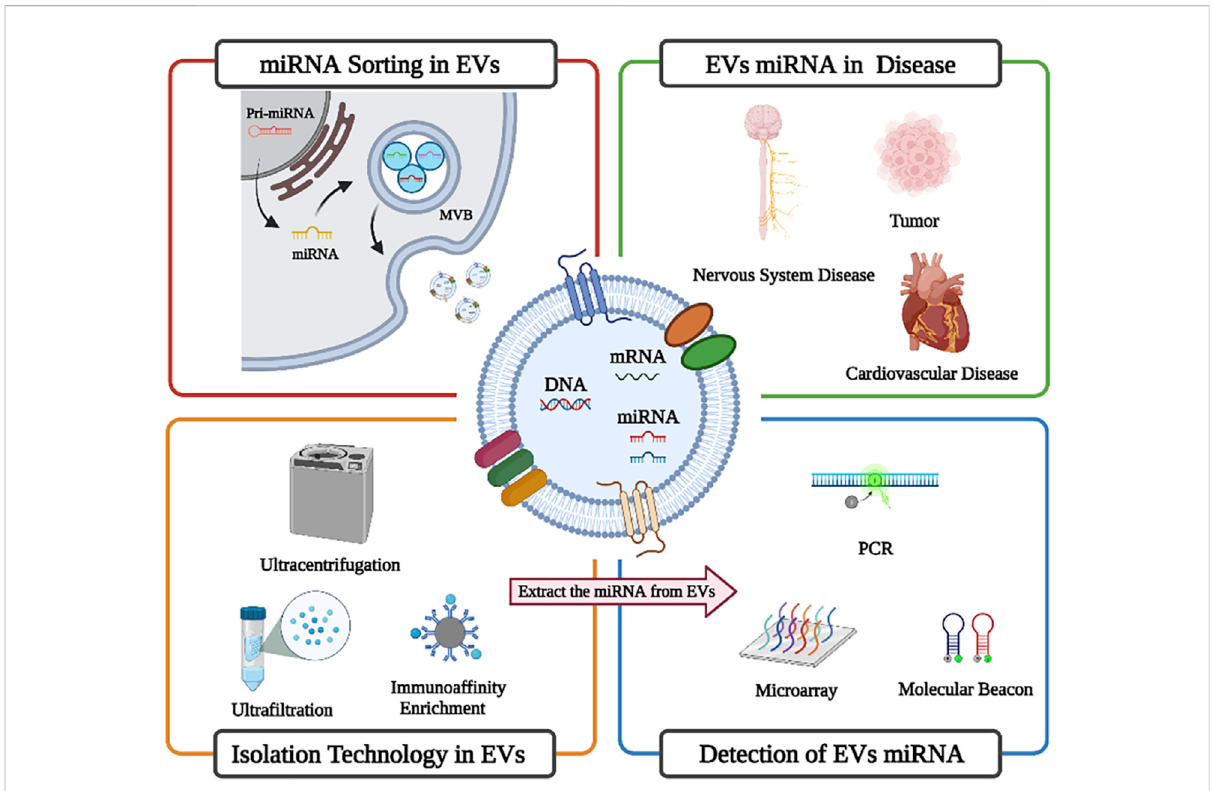
FIGURE 1 Brief overview of EV-derived miRNA sorting mechanisms, diagnostic value, isolation, and detection technology (created with